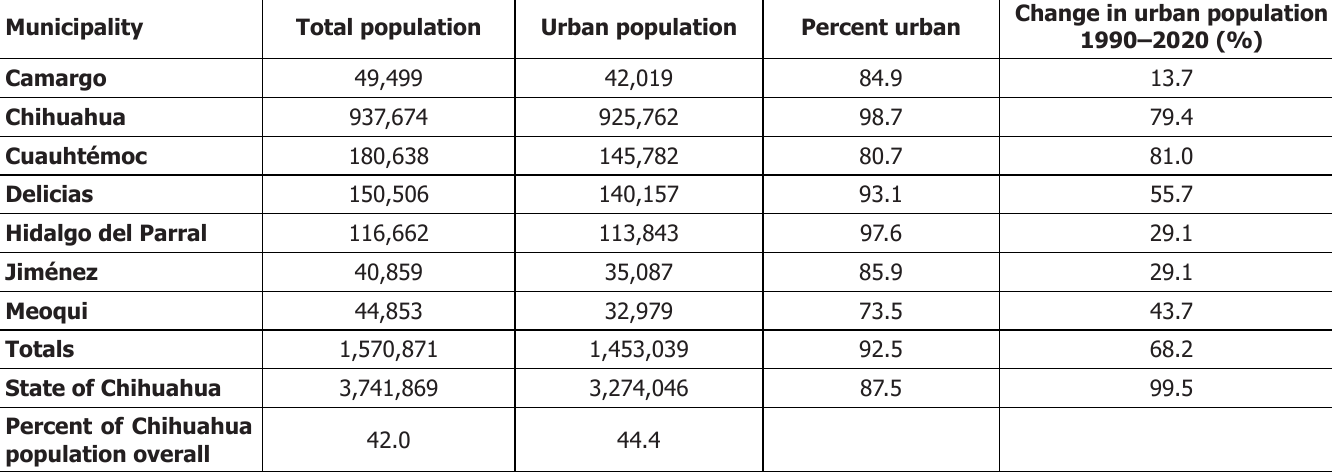
Table 4. Rio Conchos Basin urban population in largest municipalities